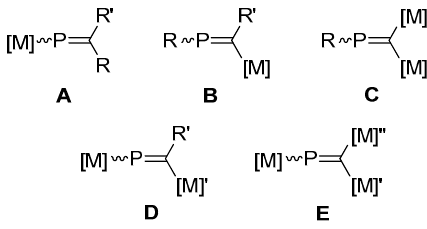
Figure 1. Metallaphosphaalkenyl motifs.